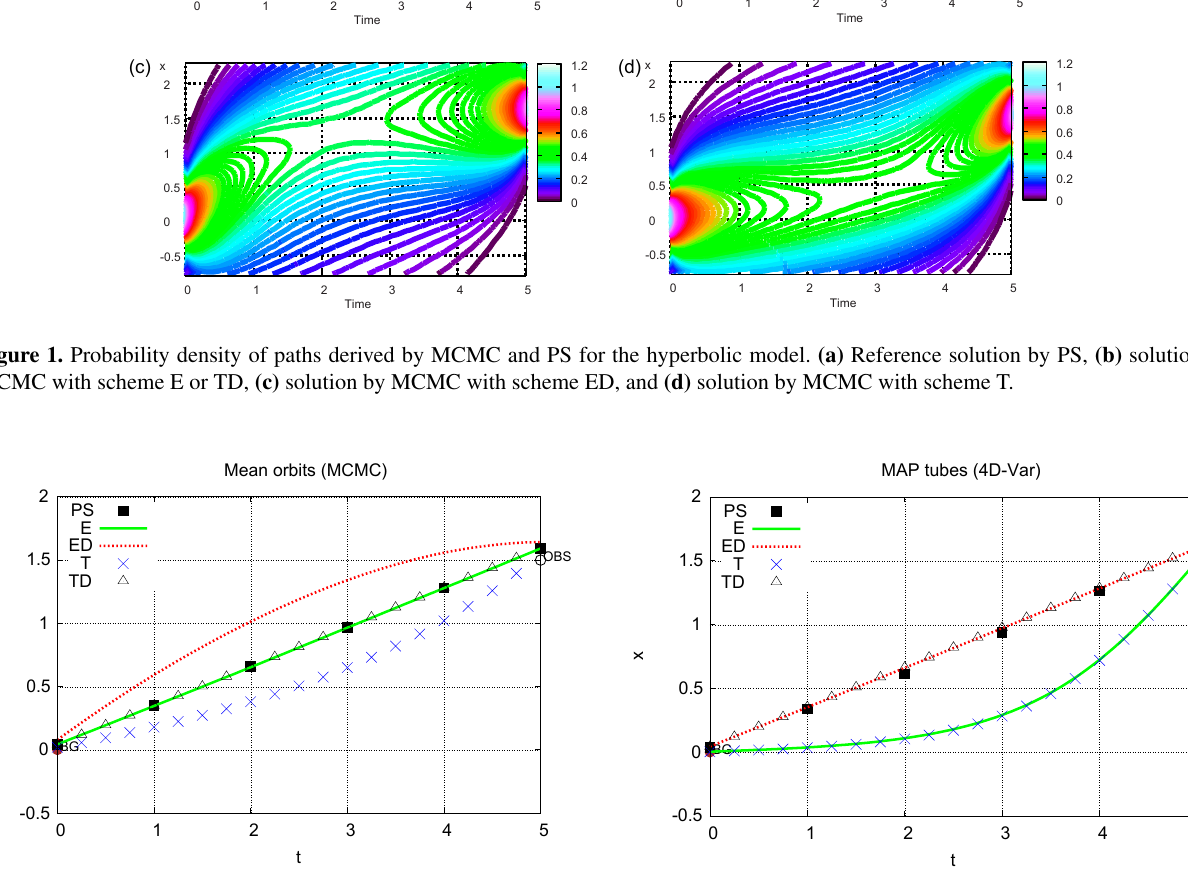
Figure 2. Expected path derived by MCMC (hyperbolic model). Figure 3. Most probable tube derived by 4D-Var (hyperbolic